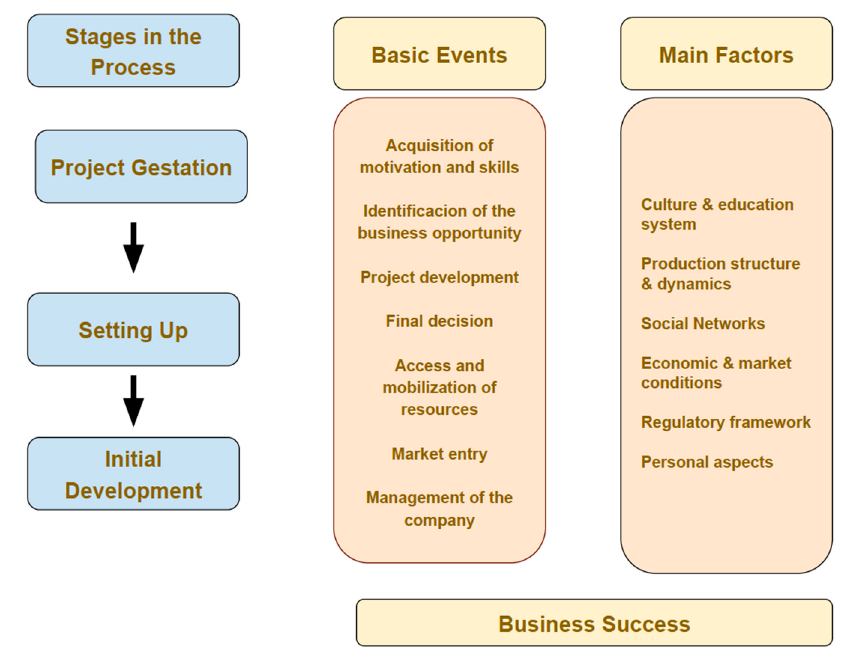
Figure 1. Entrepreneurial process. Source: Partially adapted from [27].